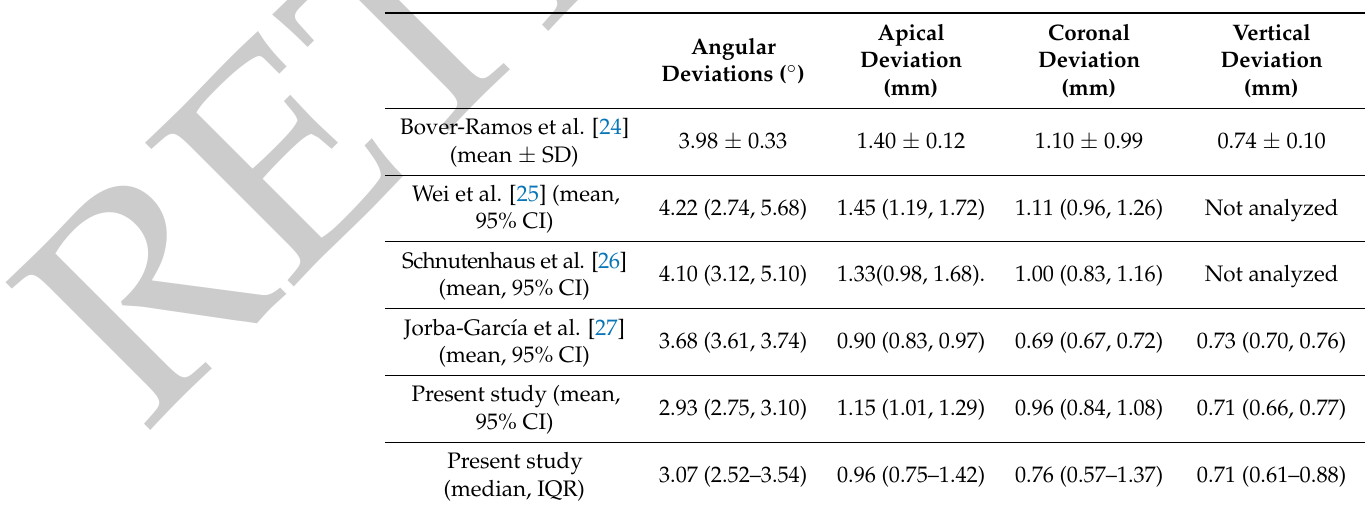
Table 2. Results of deviations in previous studies and the present